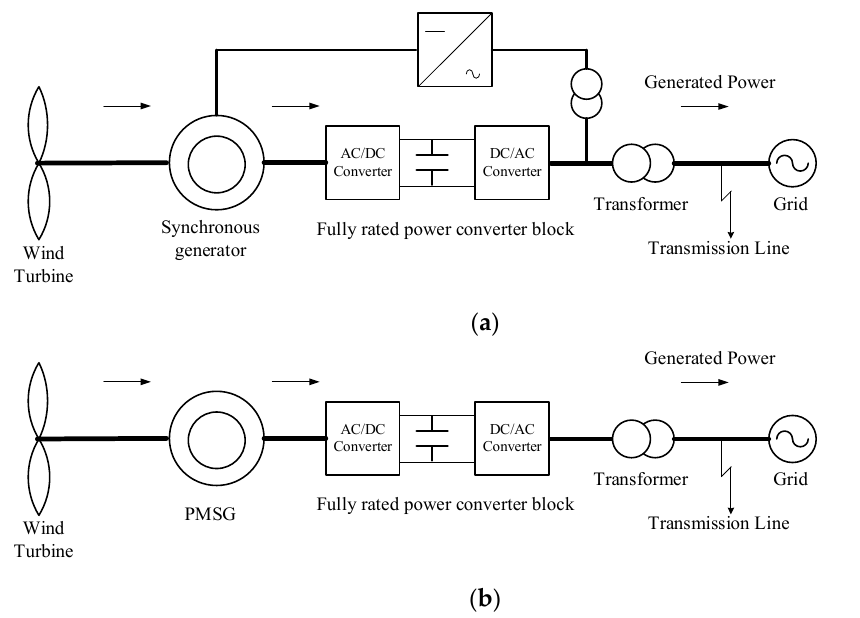
Figure 1. ( a ) Wind turbine system with full ‐ power converter generator (synchronous generator); ( a ) Wind turbine system with full-power converter generator (synchronous gen- ( b ) Wind turbine system with full ‐ power converter generator (permanent ‐ magnet synchronous erator); ( b ) Wind turbine system with full-power converter generator (permanent-magnet generator). synchronous